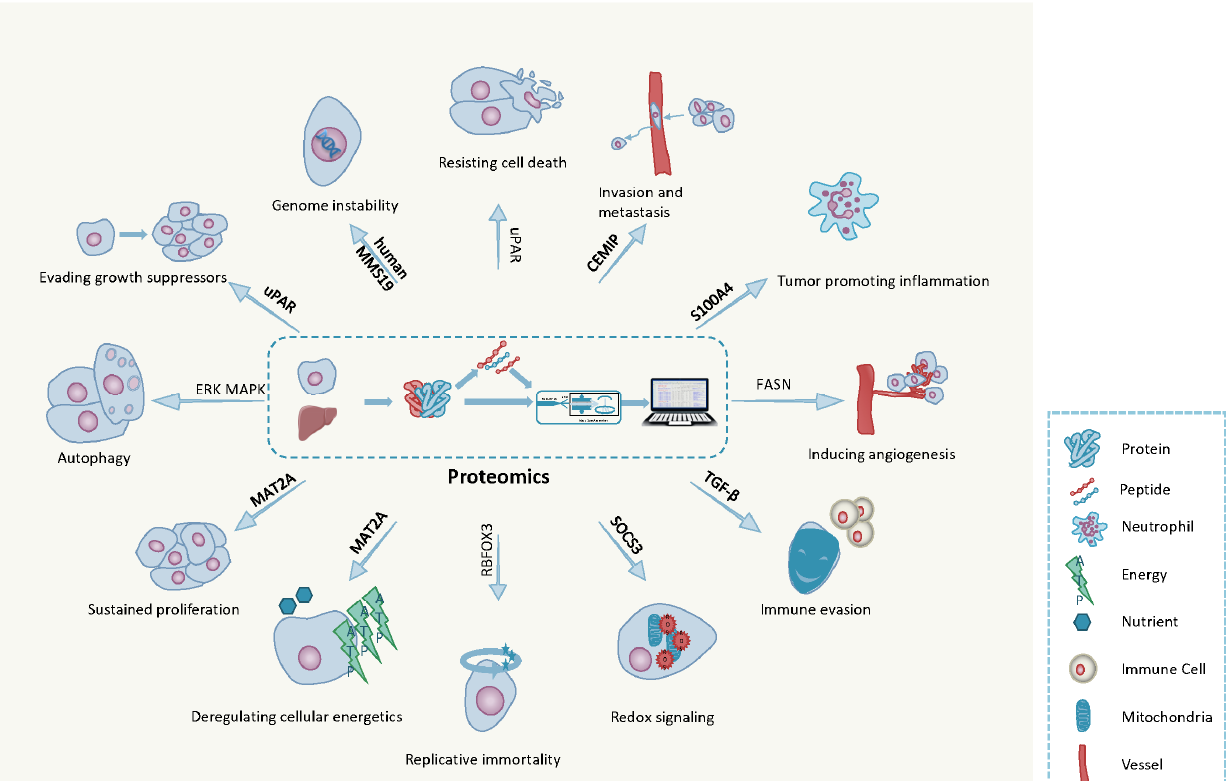
Figure 3. The Hallmarks of Cancer. Proteomics helps advance the understanding the Hallmarks of Cancer and makes a significant contribution to revealing the mechanisms behind cancer development [93–103].